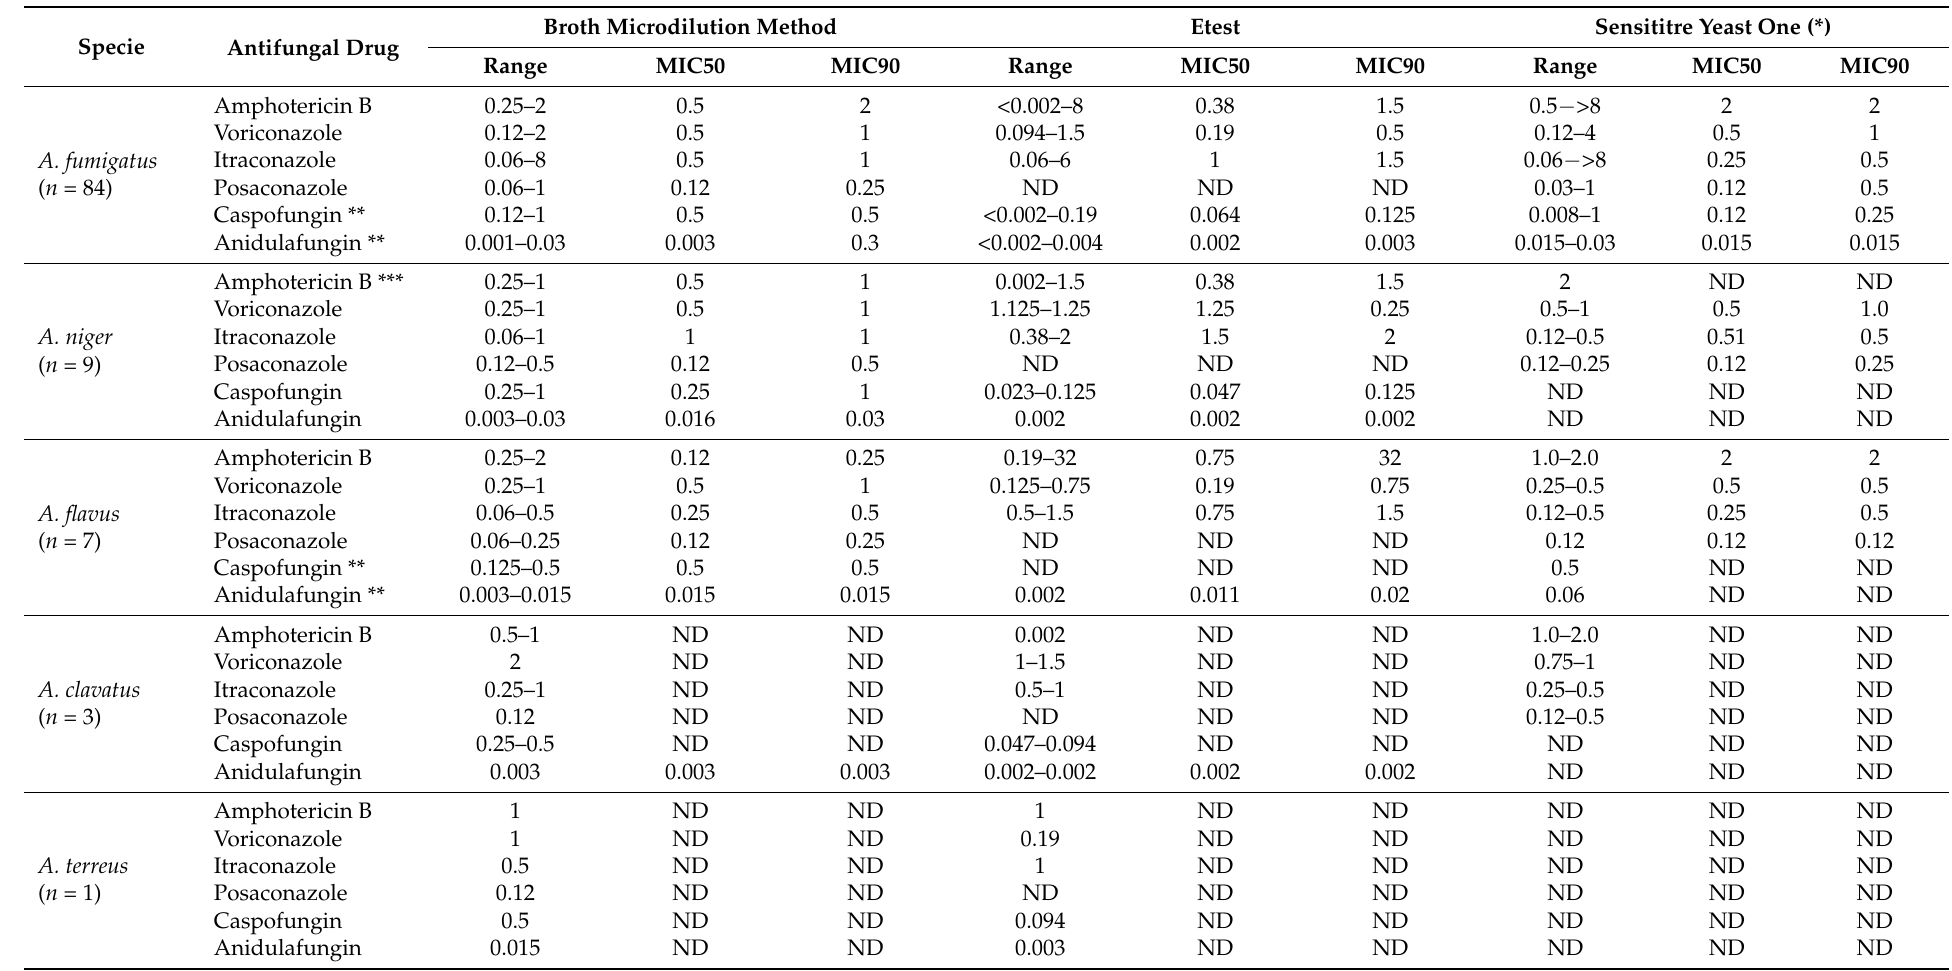
Table 2. MIC (mg/L) distribution by CLSI, Etest, and colorimetric SYO methods for 106 molecularly identified clinical isolates of Aspergillus